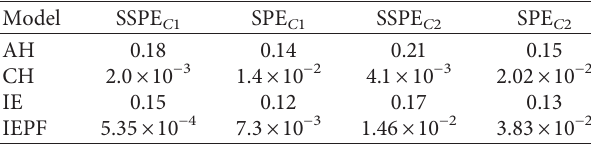
Table 14: Stability of each model for example 3.